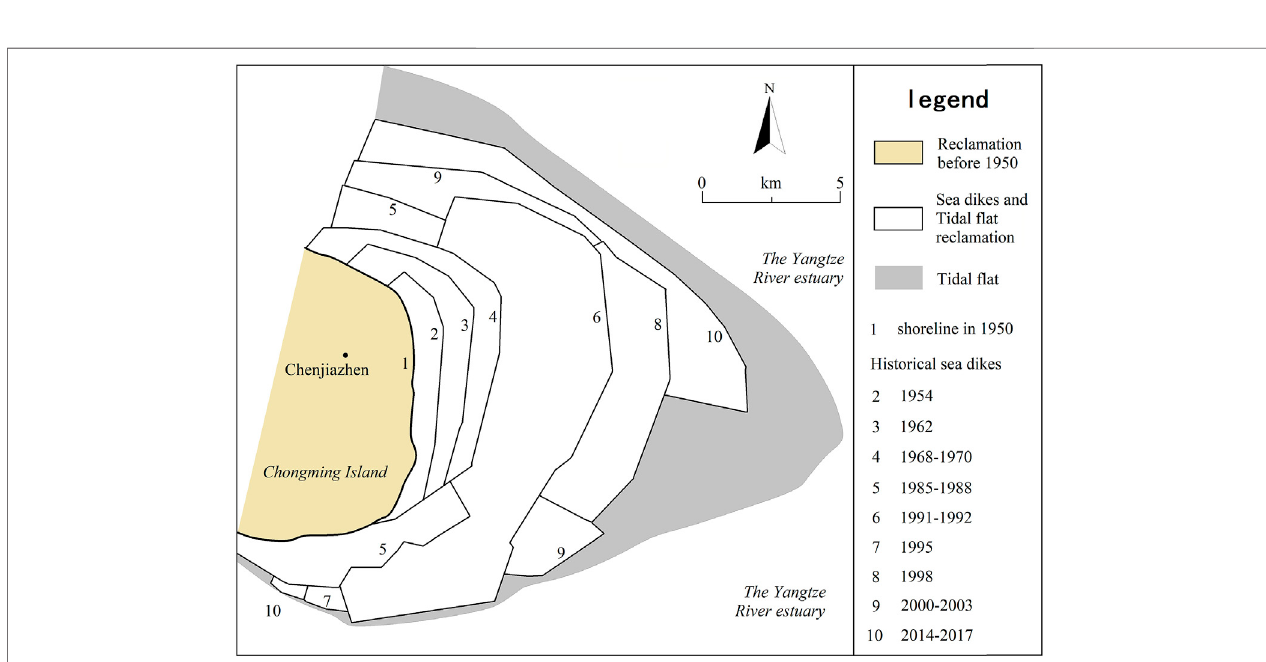
FIGURE 6 | Historical changes of sea dike and wetland reclamation in eastern Chongming Island. Data on shoreline and sea dike changes were based on Yun (2010), Yang et al. (2005), the Chronicles of Chongming County (Zhang and Zhu, 2013), the Chronicles of Chongming County (Zhou, 1989), and the Chongming Yearbook (Chongming District Statistics Bureau, 2020).